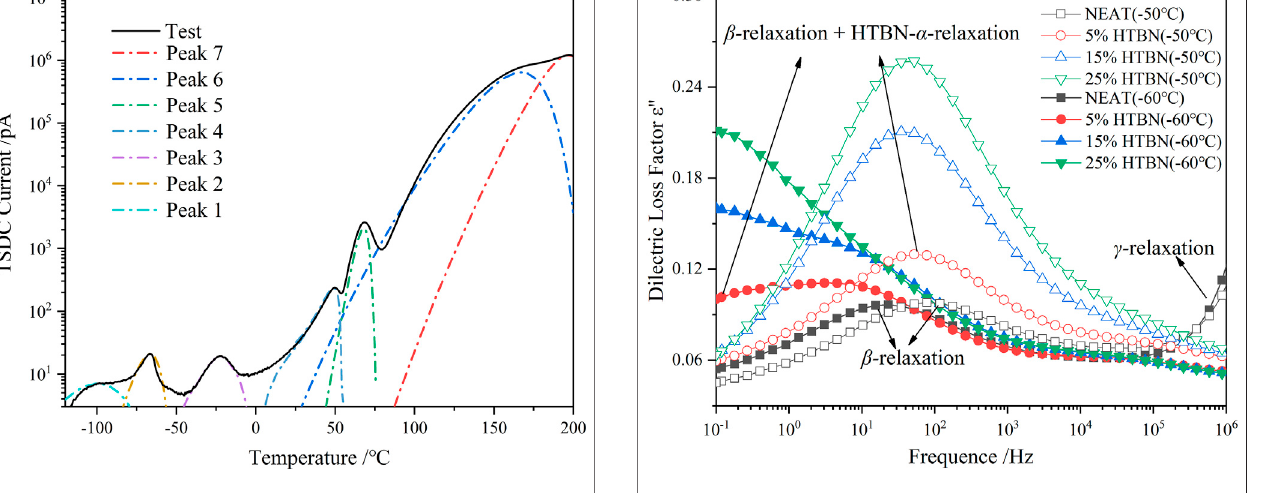
FIGURE 3 | Multi-peak fi tting of TSDC spectrum for 5% HTBN samples. FIGURE 4 | Variation of dielectric loss factor versus frequency for samples with different rubber content at low